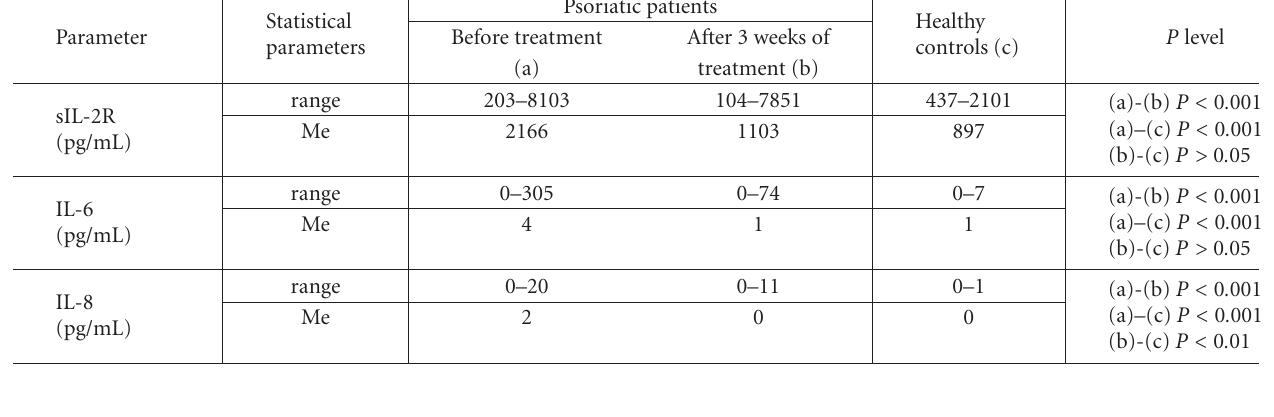
Table 1: Comparison of sIL-2R, IL-6, and IL-8 levels in plasma of psoriasis vulgaris patients before treatment and three weeks thereafter compared with healthy controls.